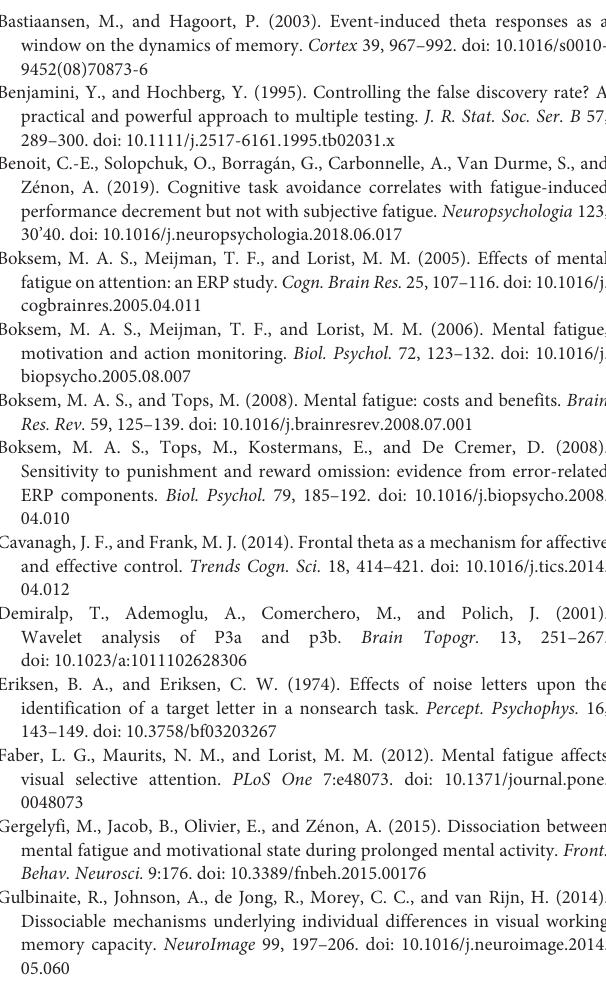
FIGURE S1 | Scatter diagrams showing the relationships between the behavioral measures (accuracy, reaction time, and number of omitted responses) and the P300 amplitude and latency in the four conditions. NRHV is block 1 in the no-reward high vigilance state, RHV is block 2 in the reward high vigilance state, NRLV is block 5 in the no-reward low vigilance state, and RLV is block 6 in the reward low vigilance state.